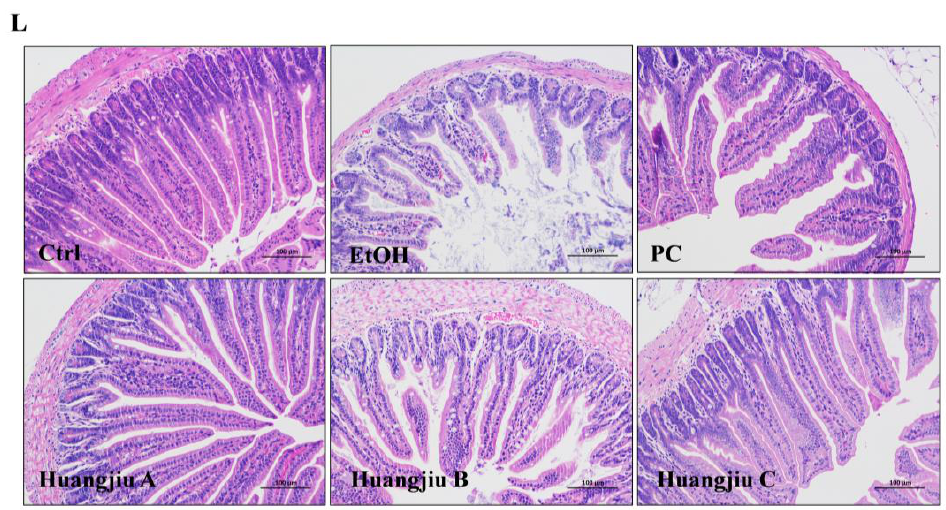
Figure 1. Effects of Huangjiu interventions on murine phenotype, biochemical and pathological indicators related to ALD. ( A ) Animal feeding schedule for Lieber-DeCarli model of chronic alcoholic liver injury. This animal model included the pair-fed control group (Ctrl, n = 10), the ethanol group (EtOH, n = 12), the positive control group (PC, n = 10), and the Huangjiu groups ( n = 30; 10 replicates for each type of Huangjiu). Mice were progressively adapted to the control liquid diet, then an ethanol liquid diet (1–4%, w/v ), and finally fed a 4% w/v ethanol liquid diet for 5 weeks. ( B ) Body weight. ( C ) Liver index. The liver index (%) was calculated as grams per 100 g body weight. ( D ) Levels of serum ALT. ( E ) Levels of serum AST. ( F ) Levels of serum TC. ( G ) Levels of serum TG. ( H ) Levels of hepatic TC. ( I ) Levels of hepatic TG. ( J , K ) Histopathological analysis of murine liver (by ( H , E ) and Oil Red O staining). Magnification × 200 and × 400. Thin arrows indicated lipid droplets. ( L ) Histological analysis of the murine ileum. Magnification × 200. Bar plot shown as mean ± standard deviation (SD) ( n = 10). Different lowercase letters indicated statistically significant differences ( p < 0.05) between the groups using one-way ANOVA followed by Fisher’s LSD test. ALT, alanine aminotransferase; AST, aspartate aminotransferase; TC, total cholesterol; TG, total triglyceride; H&E, hematoxylin and eosin.